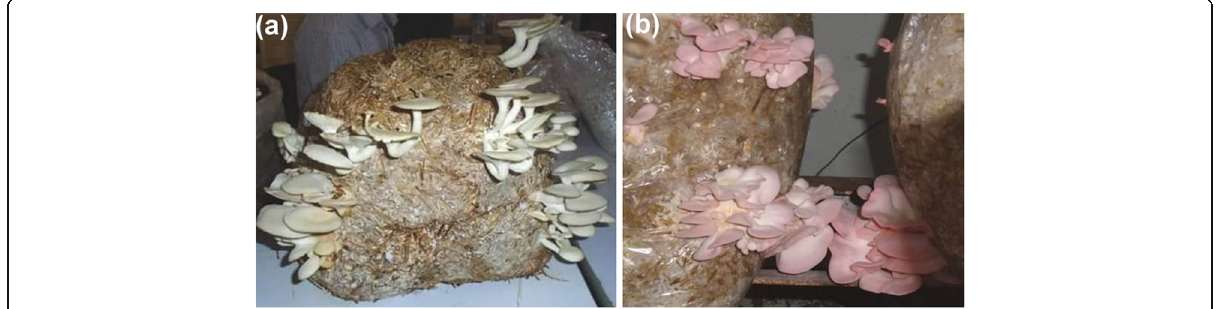
Fig. 2 The oyster mushrooms at cropping stage a Pleurotus sajor-kaju (white oyster) and b Pleurotus djamor (pink